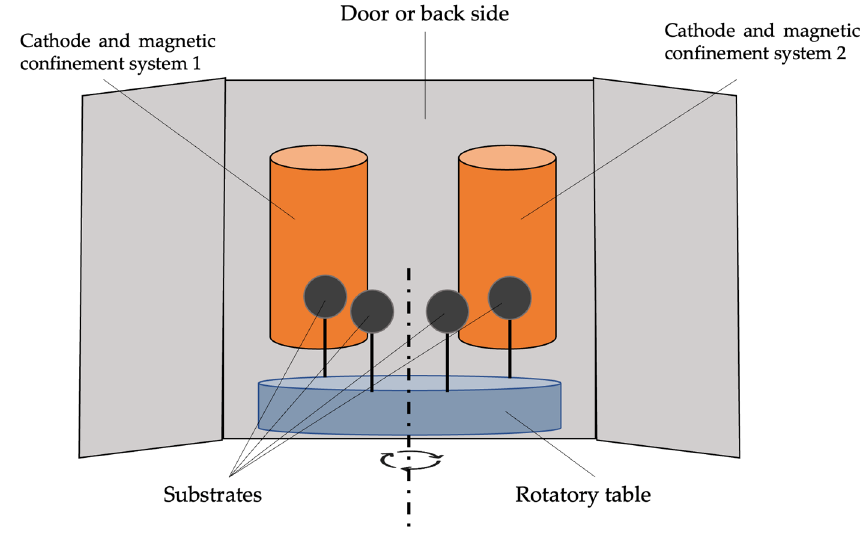
Figure 1. Schematic image of the film deposition process. Inspired by Ref. [18].